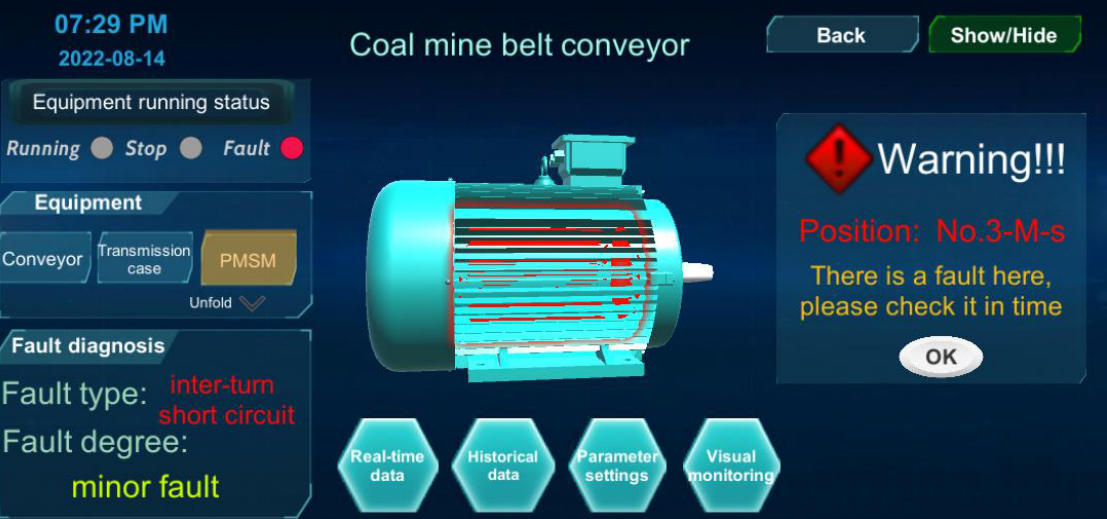
Figure 13. Digital twin fault diagnosis interface.